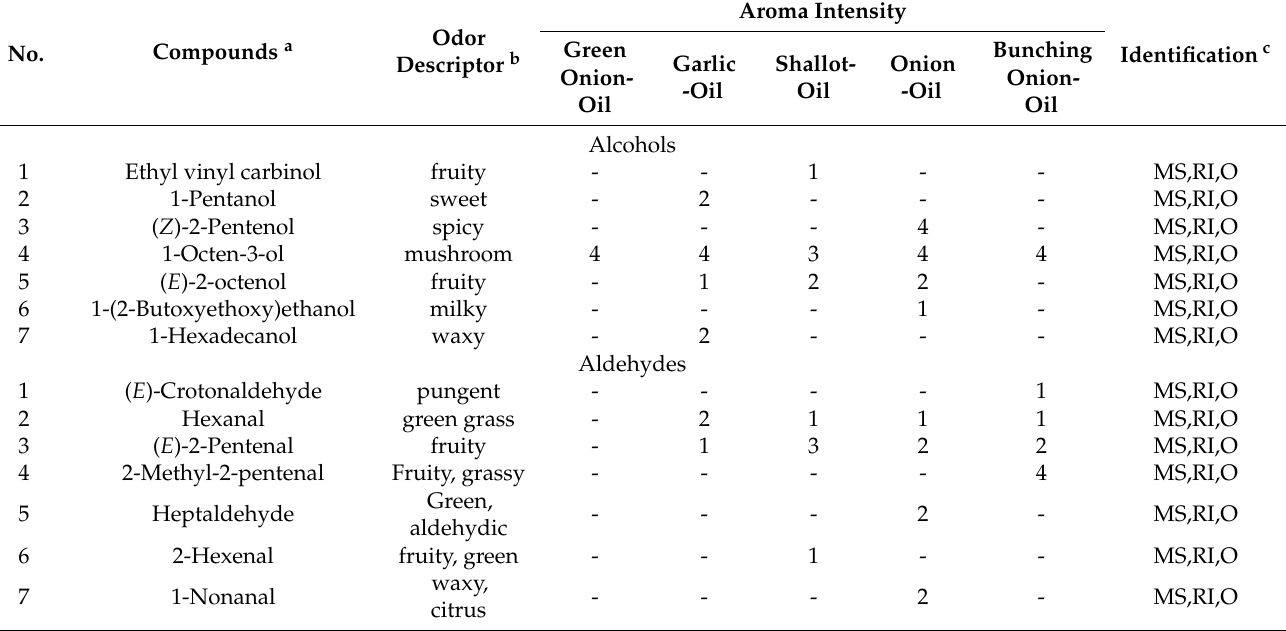
Table A2. Comparative analysis of the aroma compounds detected in five fried Allium oils by